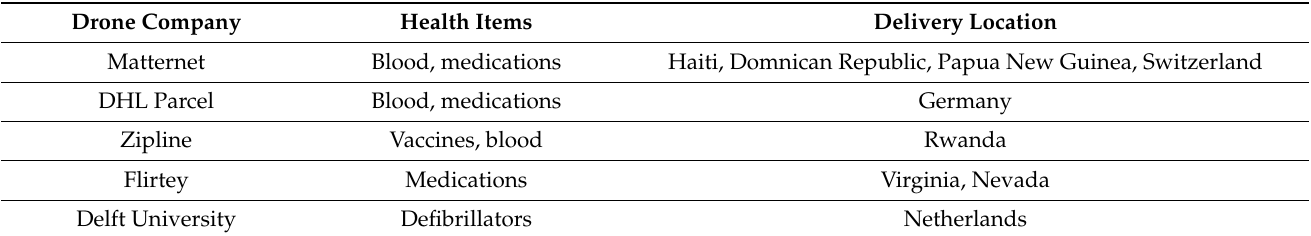
Table 2. Analysis of drones’ utility in healthcare applications.